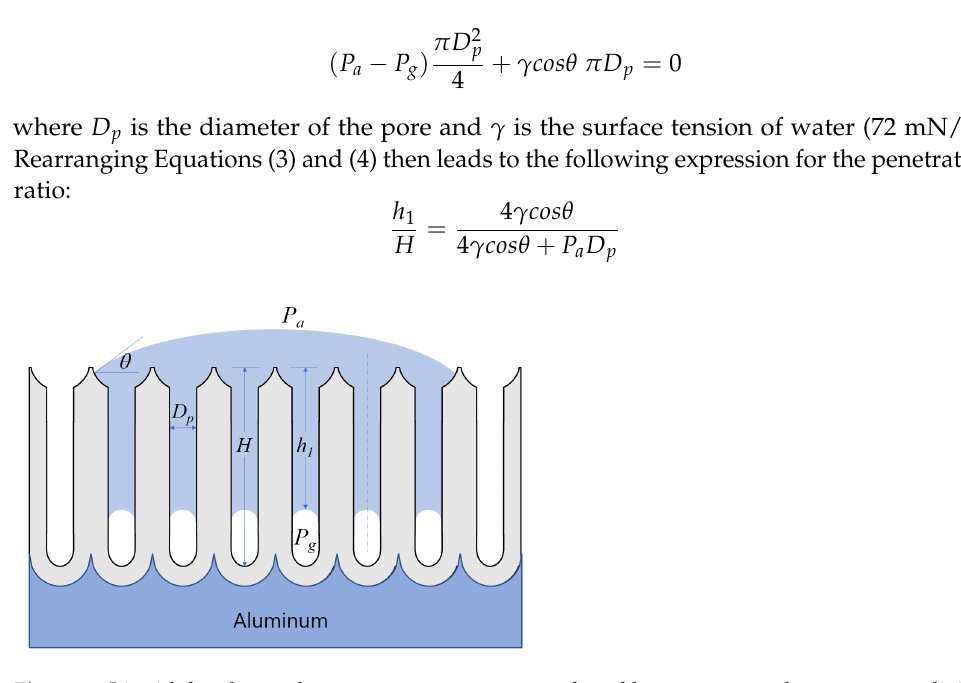
where 𝑃 (cid:3034) is the pressure of the trapped air, 𝑃 (cid:3028) is the atmospheric pressure, 𝐻 is the depth of the pore channel, and ℎ (cid:2869) is the droplet penetration depth. Given the low height